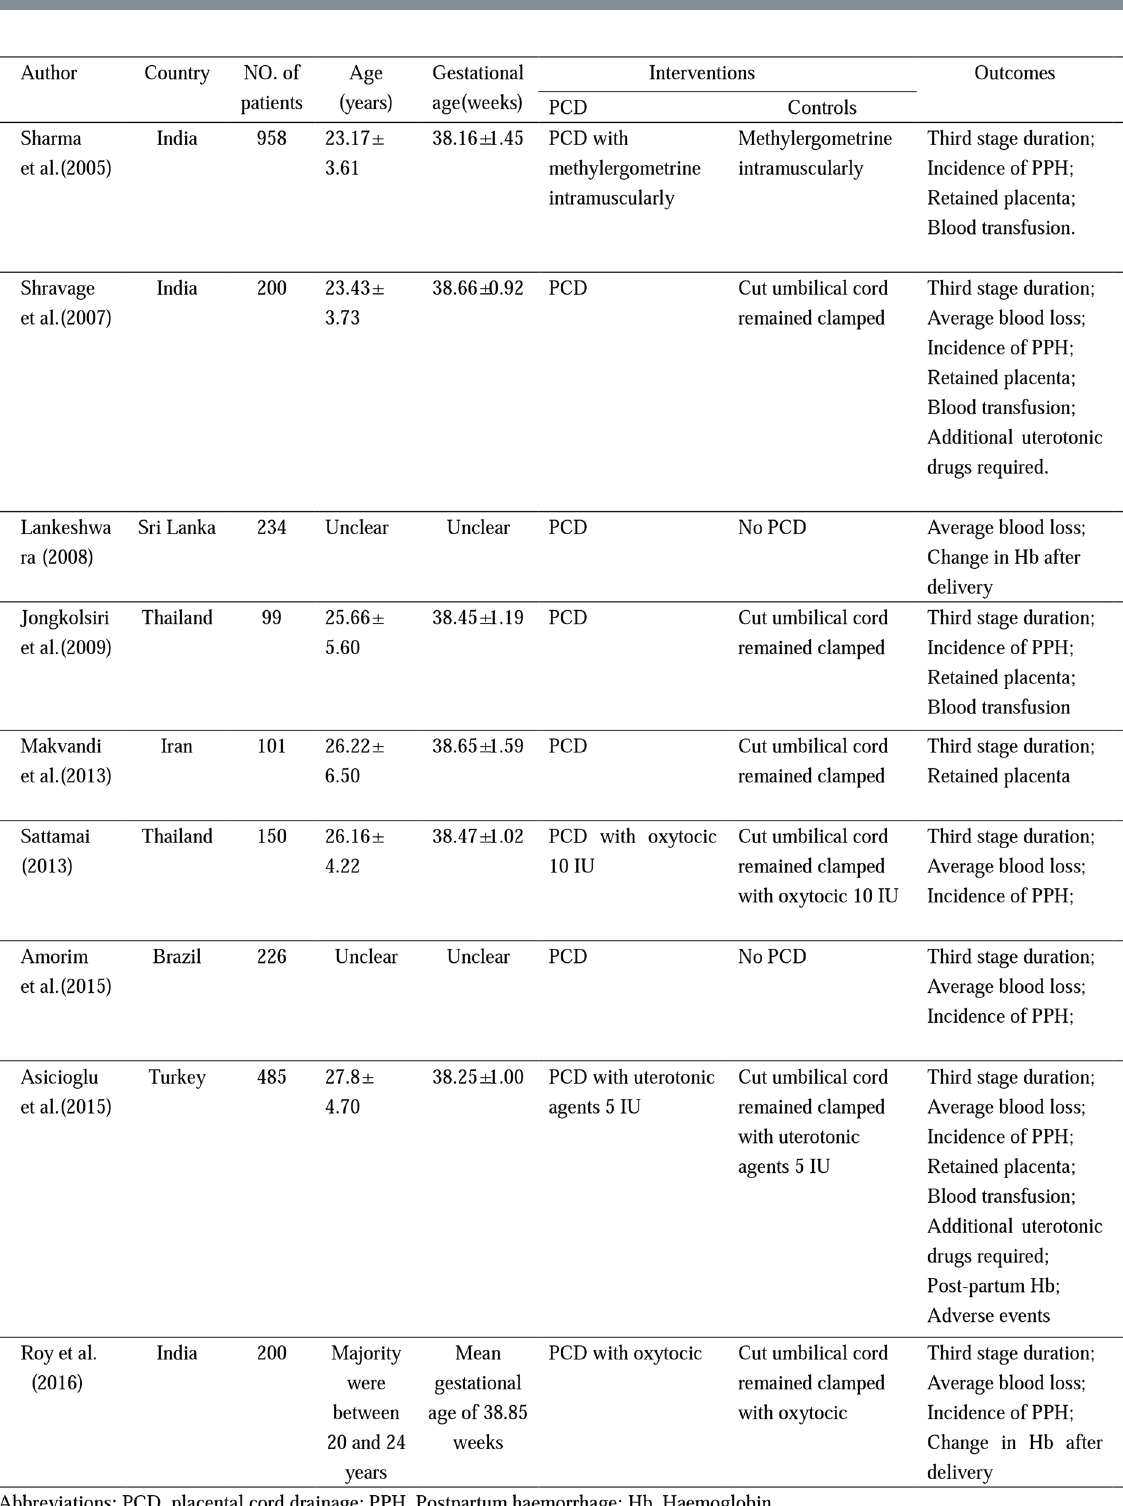
Figure 2. Characteristics of the trials identified and included in the quantitative